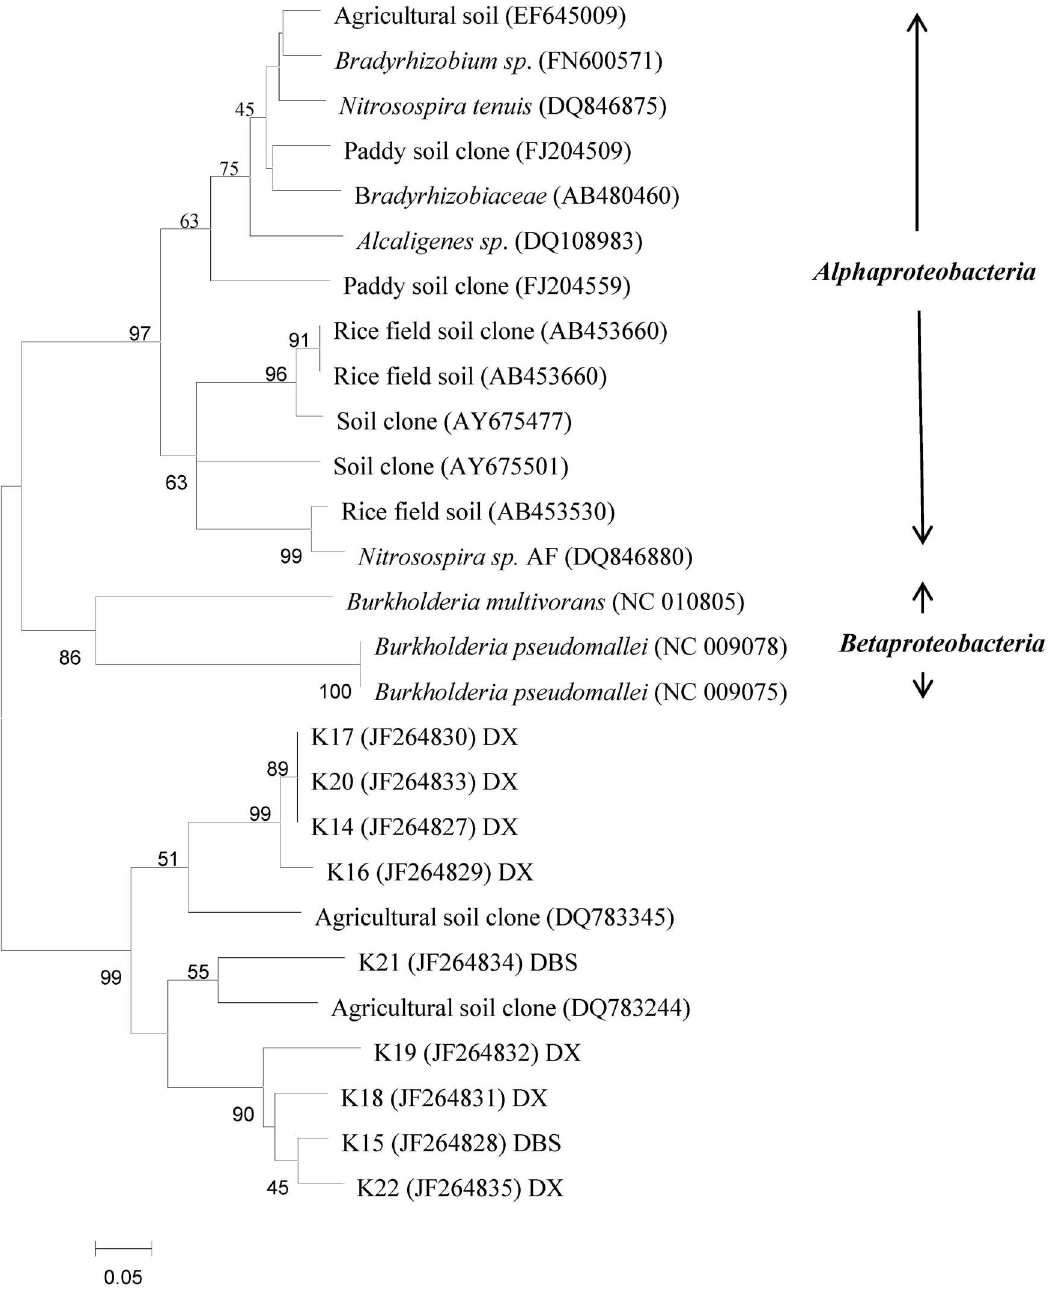
Figure 3. Neighbor-joining phylogenetic tree of nirK sequences retrieved from the numbered DGGE bands of Fig. S2(C). Designation of the clones in the dashed line frames includes the following information: excised DGGE band number, accession number in the parentheses, followed by the sampling plot the clone retrieved from. Bootstrap values ( . 40%) with 1000 replicates are indicated at branch points. Scale bar indicates 1 change per 100 nucleotide